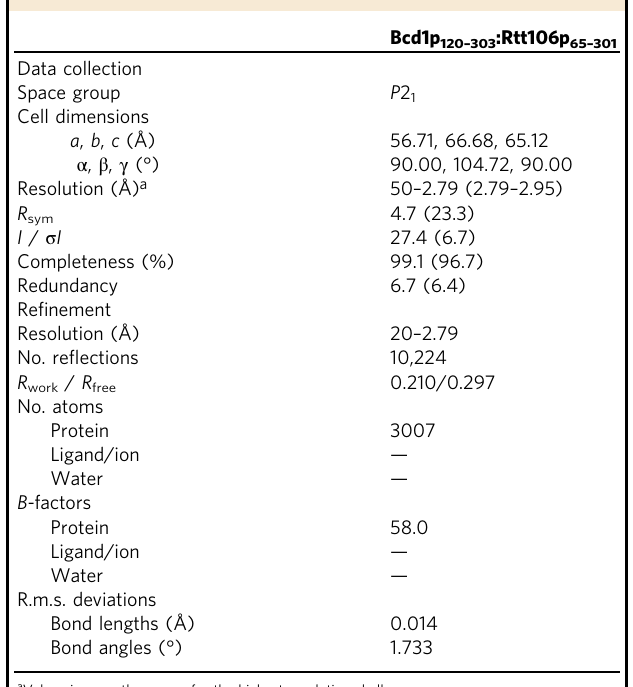
Table 2 X-ray data collection and re fi nement